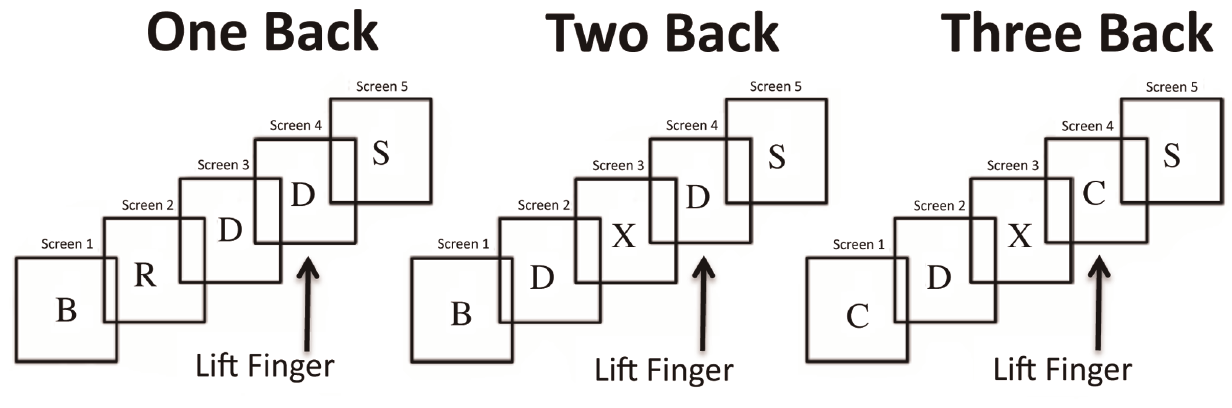
Figure 1. A diagram of the three n-back task conditions.